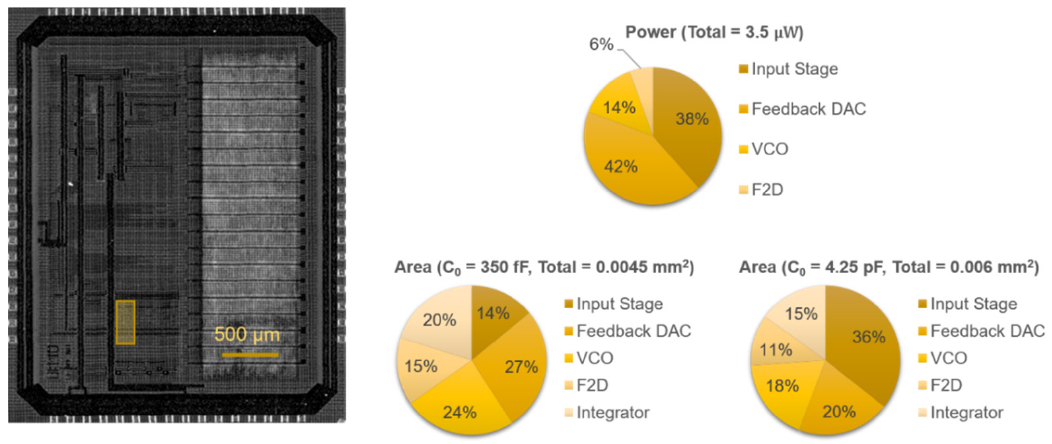
Figure 7. Chip micrograph of the prototype fabricated in 0.18 μ m CMOS, with the location of the system highlighted, and area and simulated power breakdowns.